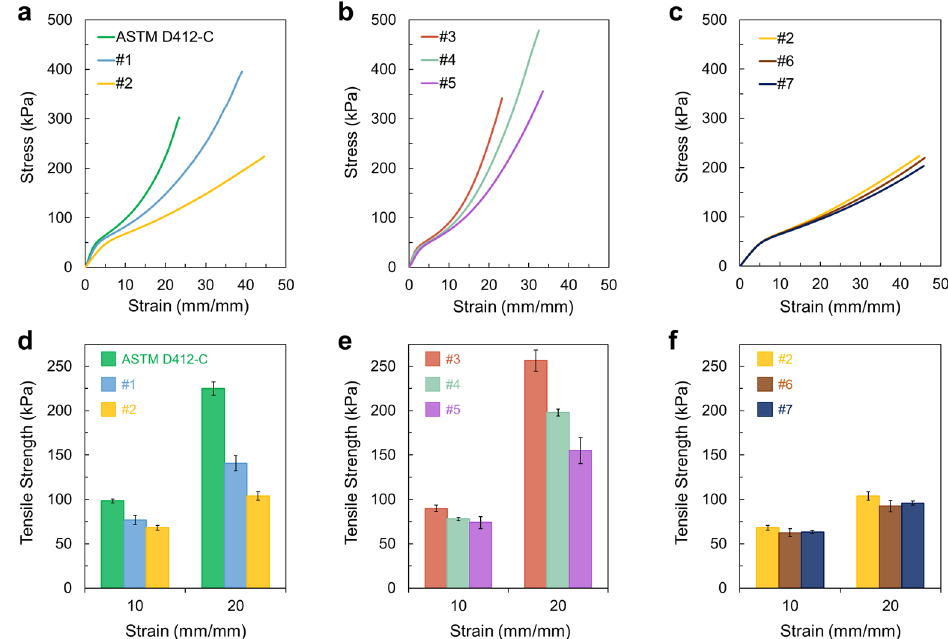
Figure 5. ( a – c ) Stress-strain curves of each hydrogel with a different specimen shape/size. ( d – f ) Tensile strength values at a strain of 10 or 20.